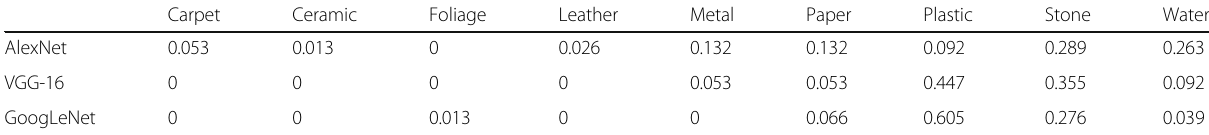
Carpet Ceramic Foliage Leather